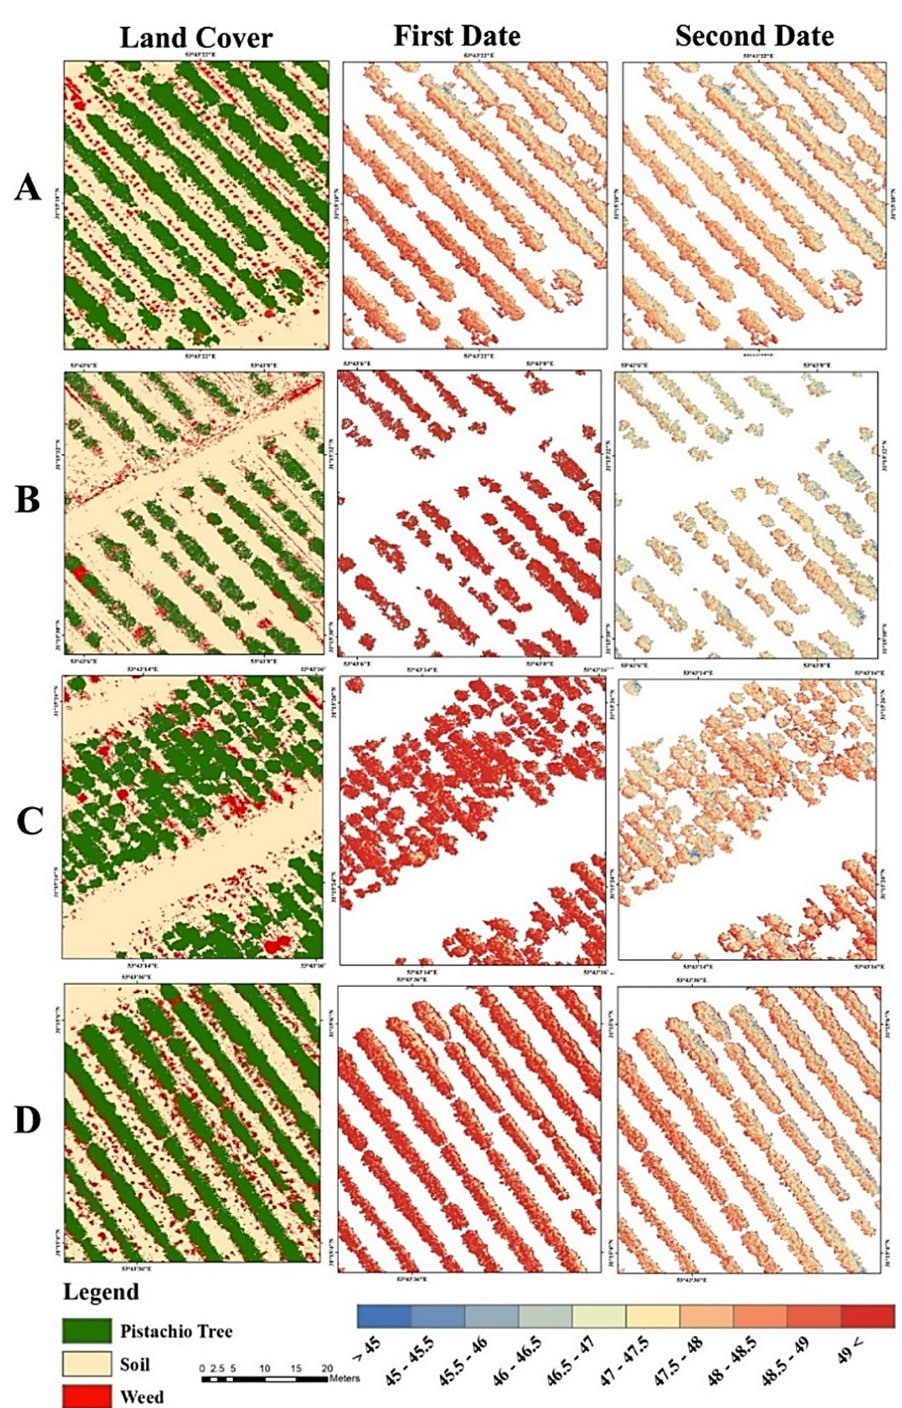
Figure 6. Comparison of the surface temperature of pistachio trees after foliar application of gypsum on the first imaging date (plot ( A ) only) and of gypsum again, gypsum, NAX-95 (calcium-based suspension coating), and sulfur in plots ( A ), ( B ), ( C ), and ( D ), respectively, on the second date.